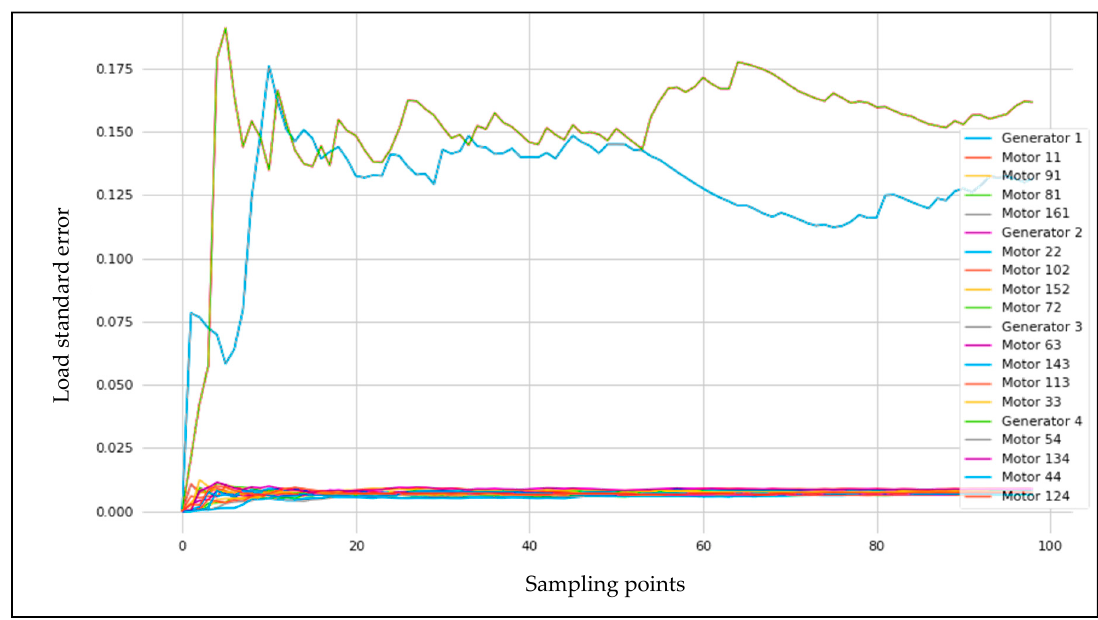
Figure 24. Monte Carlo standard deviation for the cruising case study. Figure 24. Latin hypercube standard deviation for the TO case study. Figure 23. Latin hypercube standard deviation for the TO case study.